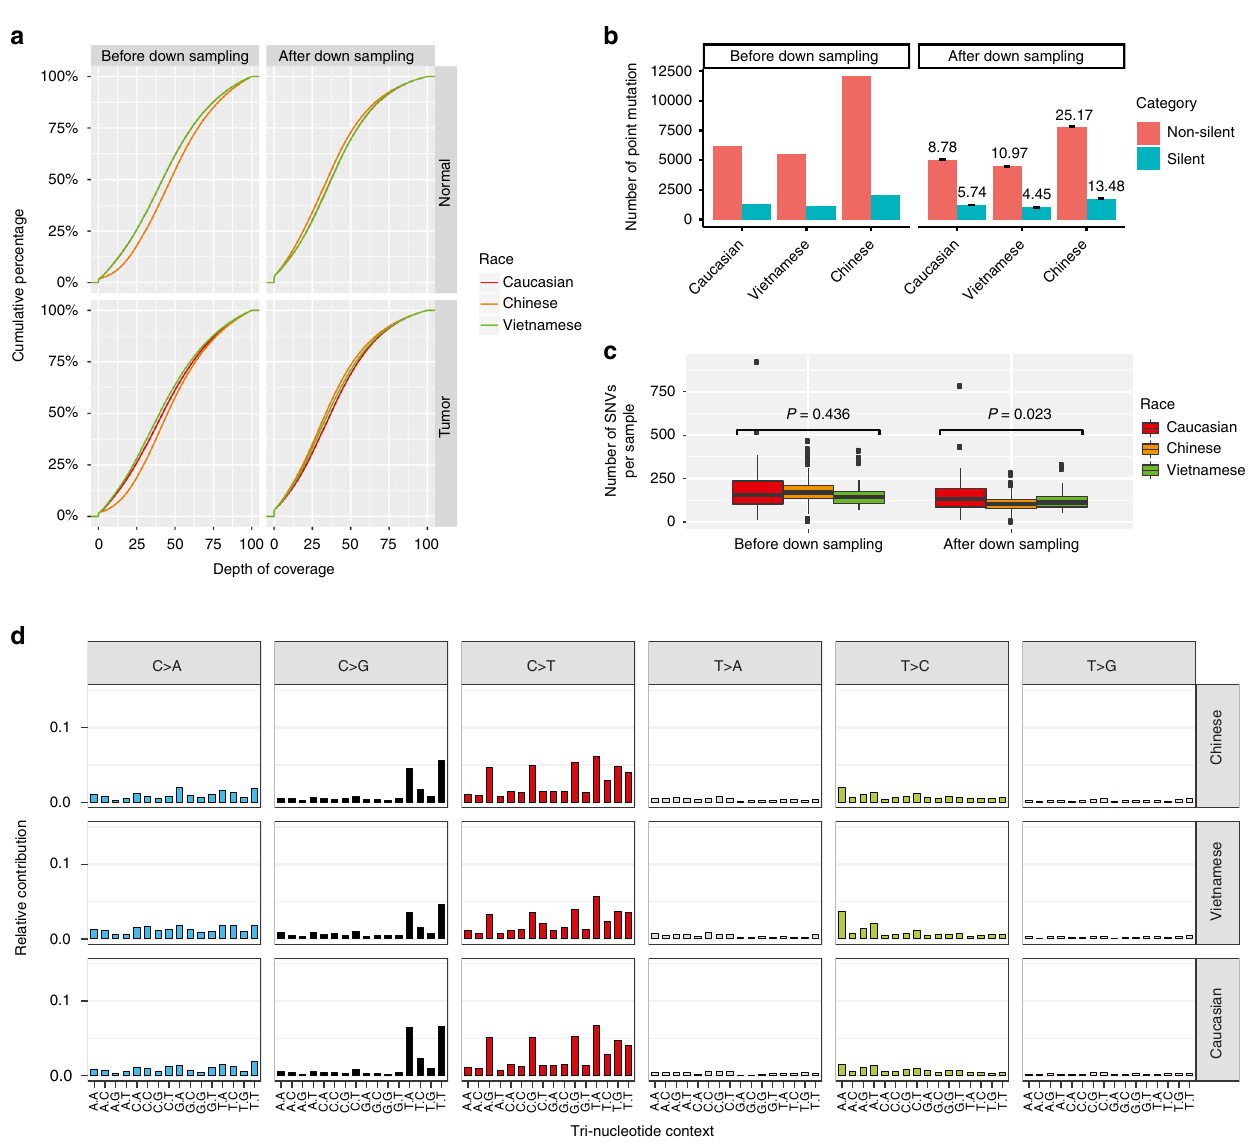
Fig. 3 Comparison of mutational patterns of different ESCC patient populations. a Distribution of depth of coverage of exons captured in WES. Chinese tumors and matched normal tissues had higher depth of coverage than those of TCGA ESCC cases before downsampling. After downsampling, the three patient cohorts had similar distributions of depth of coverage. b The number of somatic mutations for each patient cohort before and after downsampling. The error bars and numbers on the top of the bars were calculated based on mutation calls from 10 downsampling iterations. c Box plots showing the distribution of the number of somatic mutations in each sample in the three cohorts before and after downsampling. The center lines in the boxes are the median numbers of somatic mutations for different patient cohorts, while the upper and lower hinges are the 25th and 75th percentiles. Whiskers above and below the boxes indicate 1.5 times interquartile range. Individual points are those outside of the range. d Mutational signature of each cohort